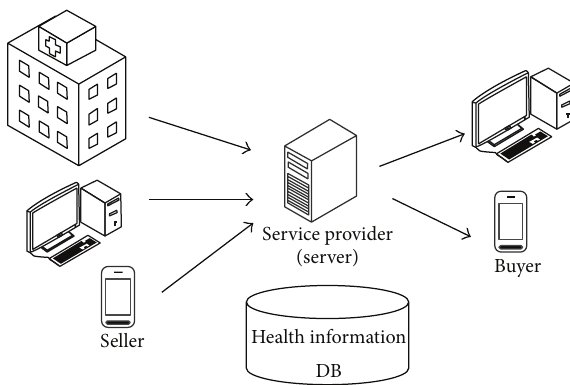
Figure 11: Buying/selling health information